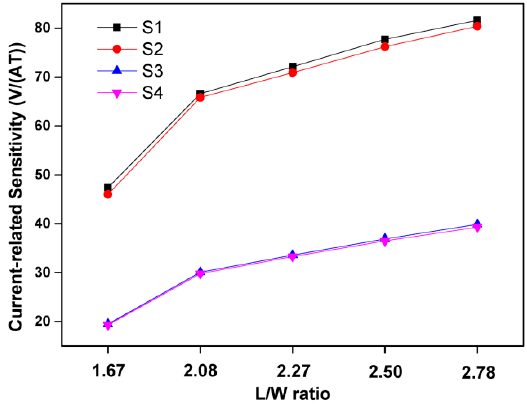
Figure 6. Relationship between L/W ratio and current-related sensitivity of S1, S2, S3 and S4.